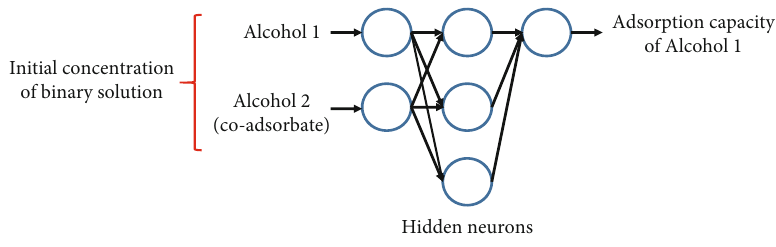
Figure 1: Arti fi cial neural network used to model the adsorption of bioalcohols on bone char.